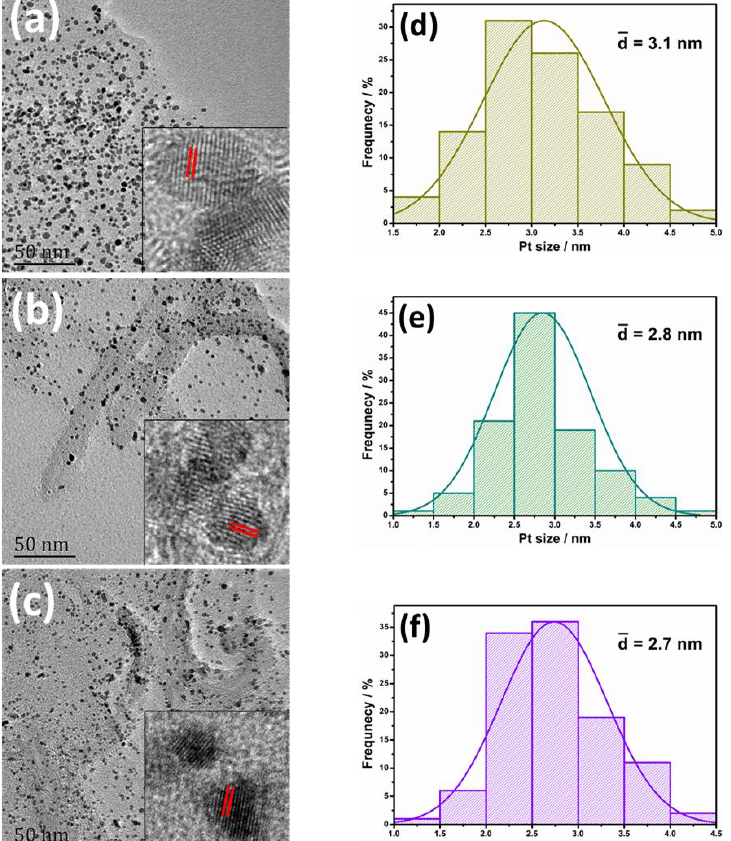
Figure 3. TEM images for ( a ) Pt/G, ( b ) Pt/G-M, and ( c ) Pt/N-G-M catalysts, and the corresponding particle size distribution curves for ( d ) Pt/G, ( e ) Pt/G-M, and ( f ) Pt/N-G-M catalysts. Insets show the corresponding HRTEM images.